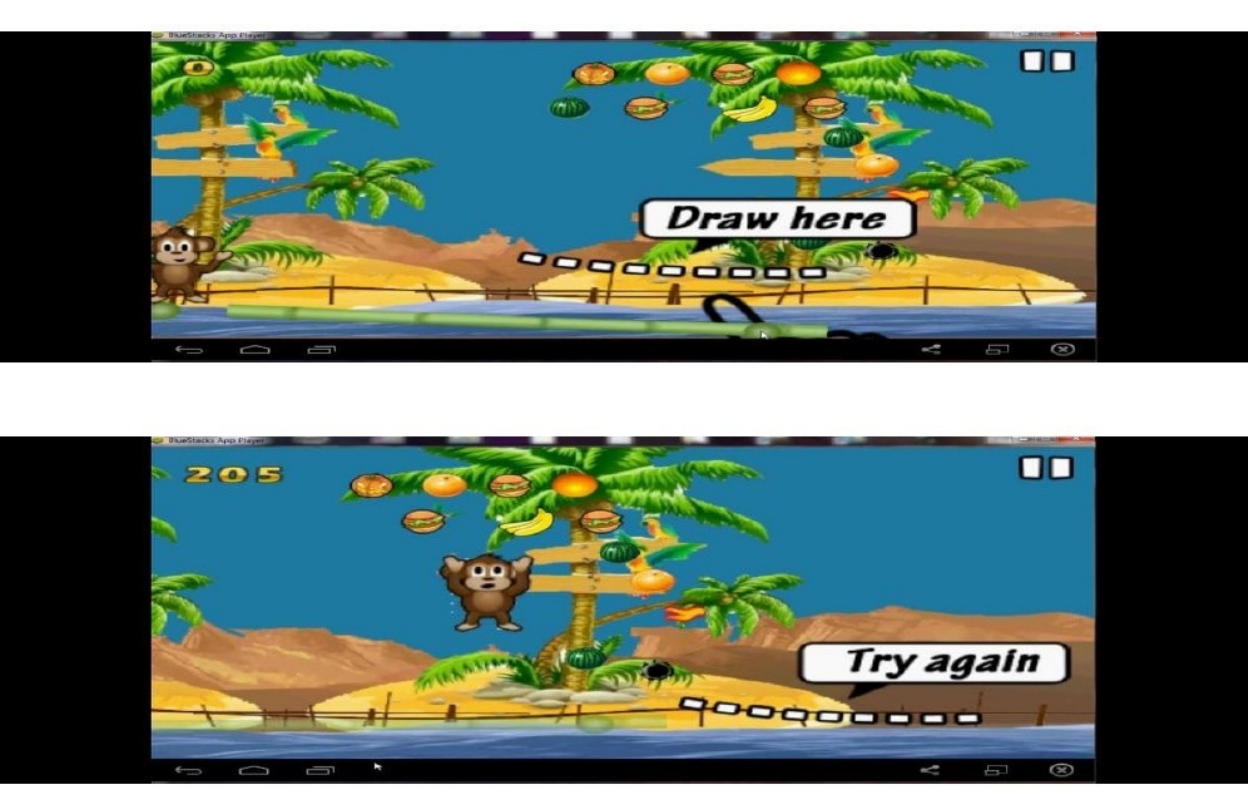
Figure 4. Mobile game applying the scaffolding strategy.